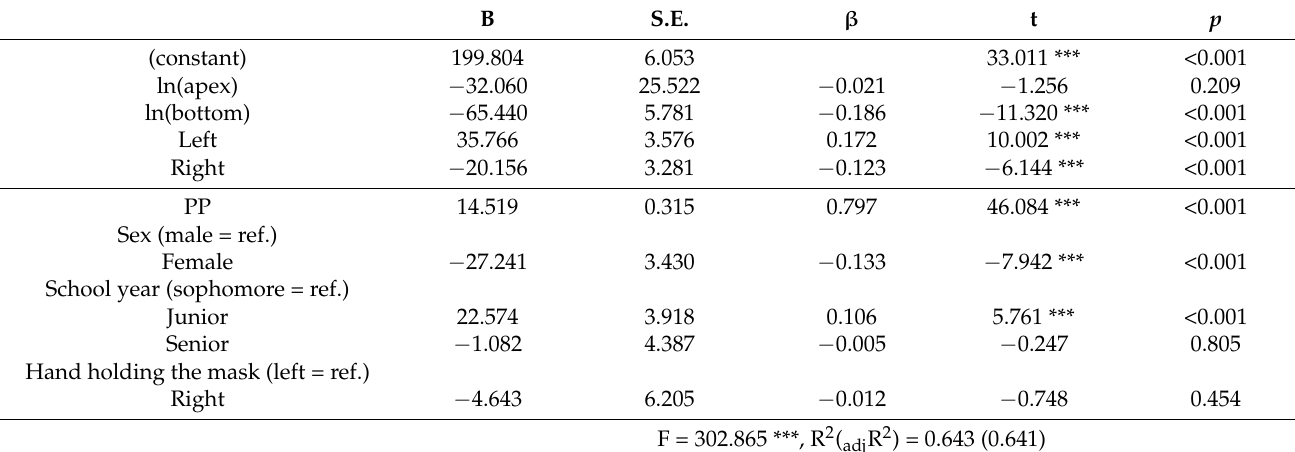
Table 4. Factors influencing the tidal